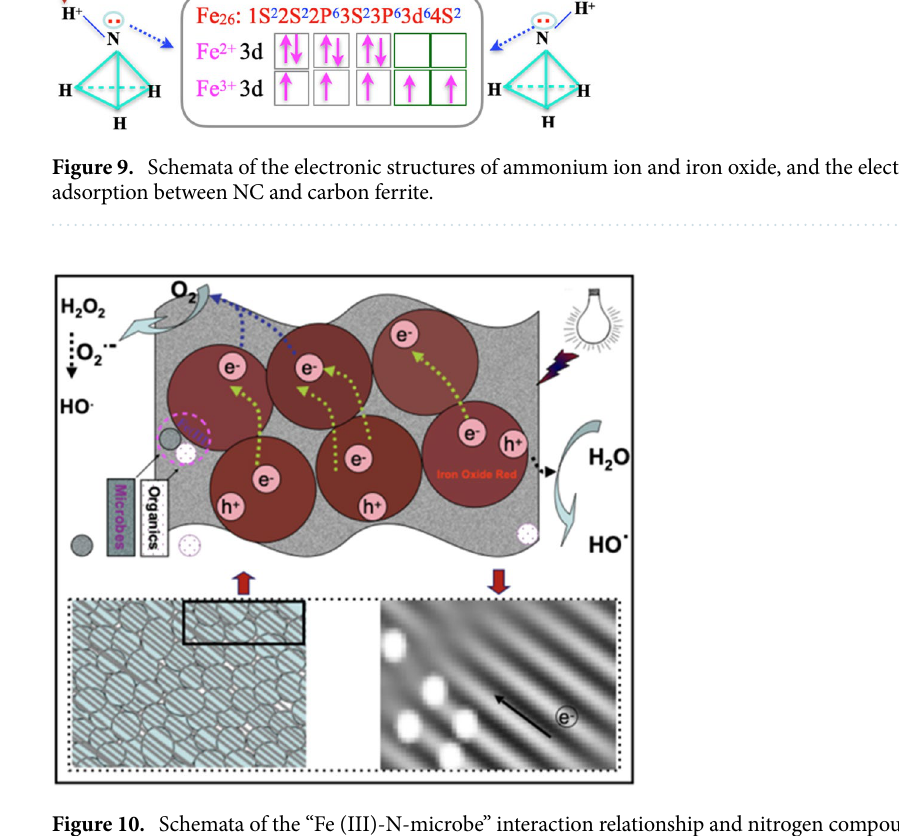
Figure 10. Schemata of the “Fe (III)-N-microbe” interaction relationship and nitrogen compounds photocatalytic